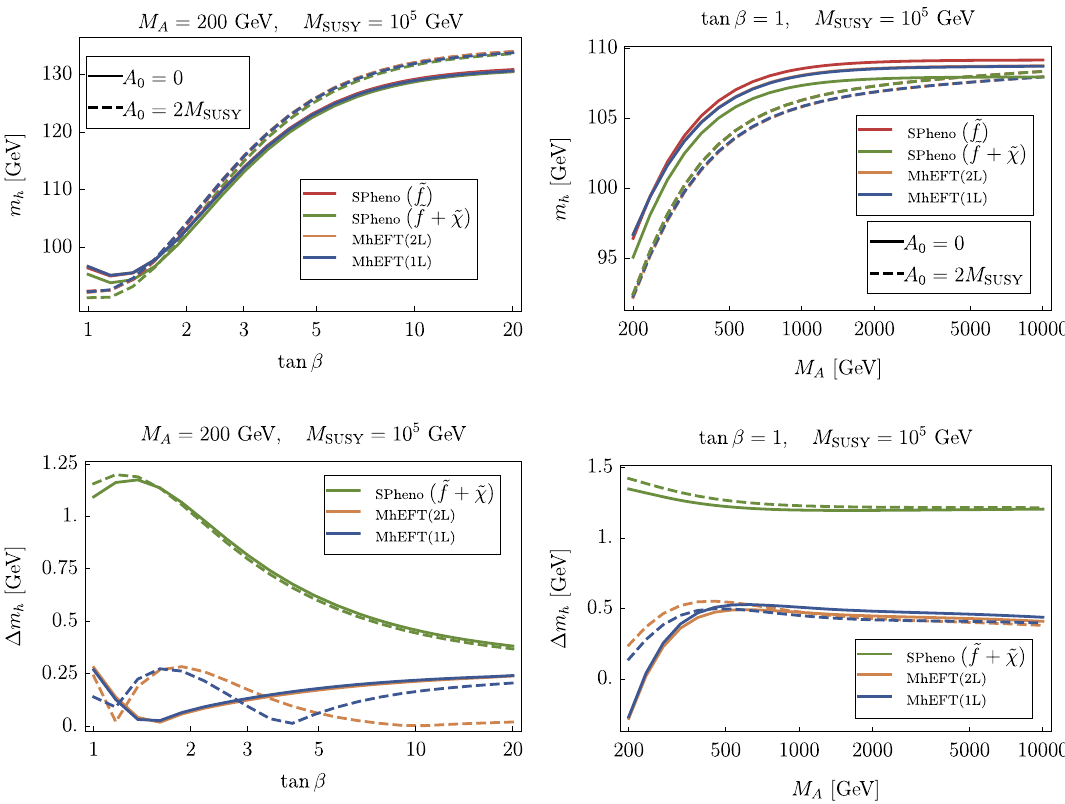
Fig. 11 Comparison between MhEFT and SPheno for a variation of tan β (left) or M A (right). All SUSY masses are assumed to be degenerate and identical to M SUSY , and the results for two different values of A 0 are shown